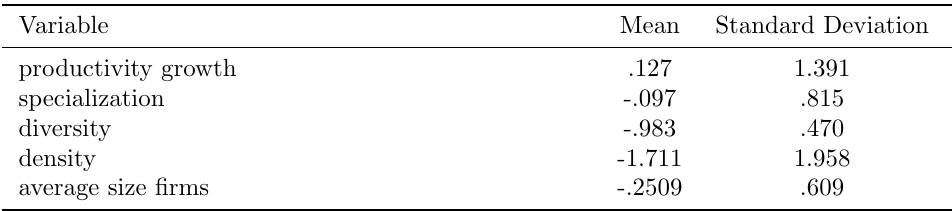
Table 1: Summary statistics of the main